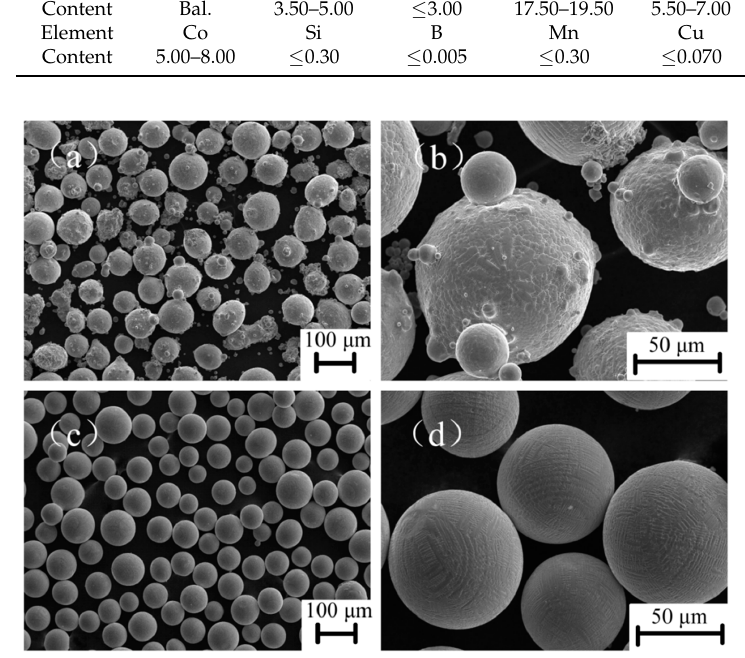
Figure 1. SEM morphology of pre-alloyed GH4099: ( a,b ) GA; ( c,d ) PREP.